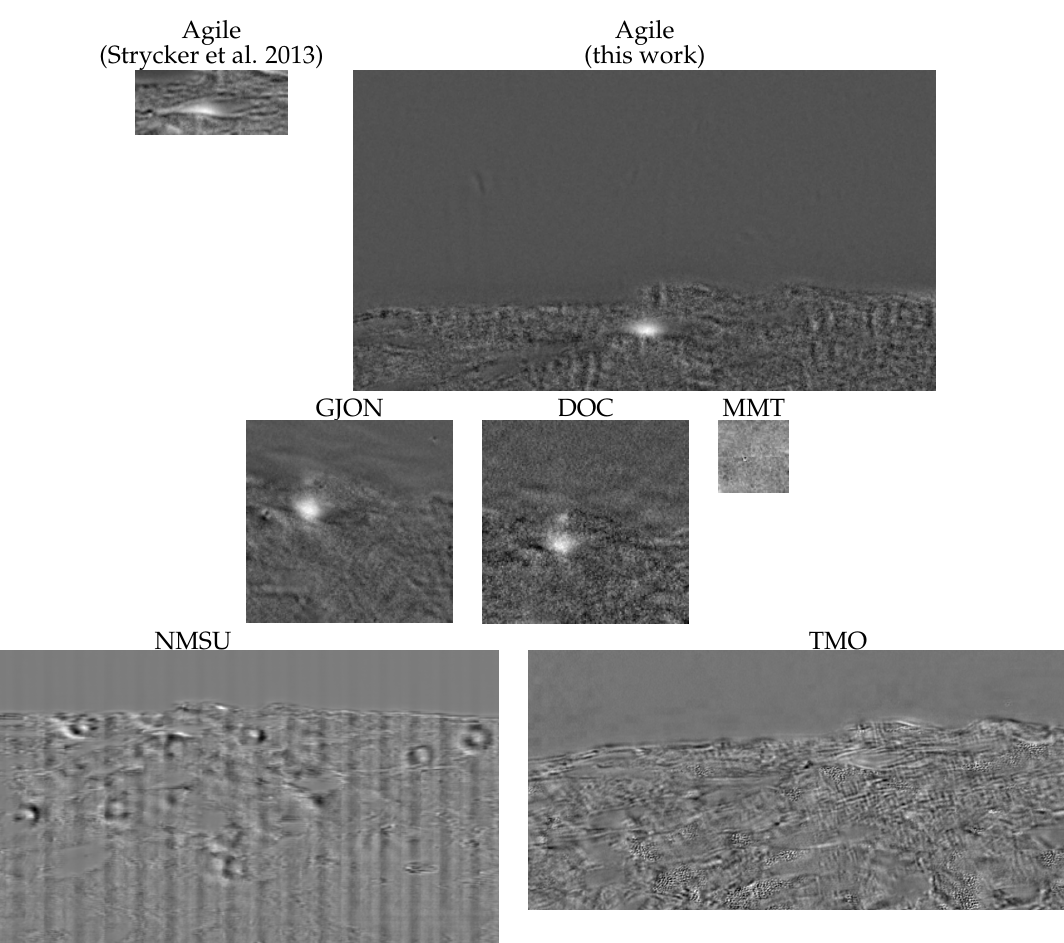
Figure 3. The PCA-filtered data averaged over post-impact times from 17 to 27 s reveal plume detec- tions in Agile, GJON, and DOC. The Strycker et al. [13] data reduction is included for